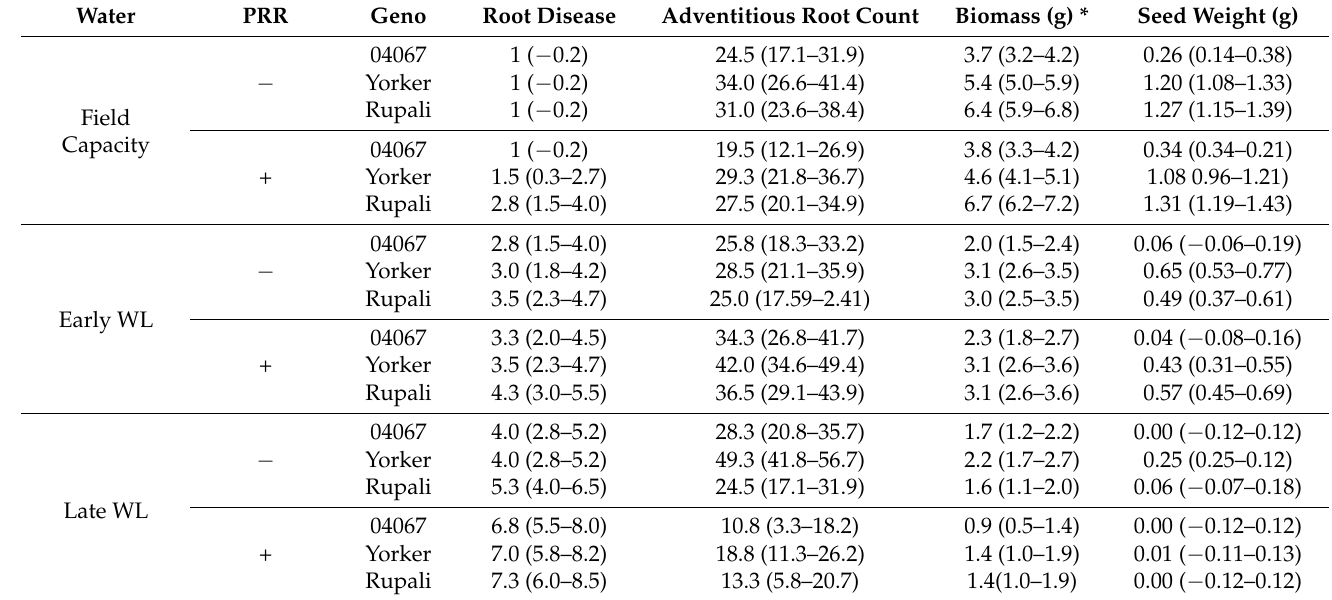
Table 2. Mean values and 5–95% CI in parentheses for the three-way GLMM for early and late vegetative waterlogging (WL) and P. medicaginis infection (PRR) for disease and growth parameters of three chickpea genotypes (Geno) C. echinospermum BC PRR moderately resistant 04067, C. arietinum PRR moderately susceptible Yorker and PRR very susceptible Rupali.